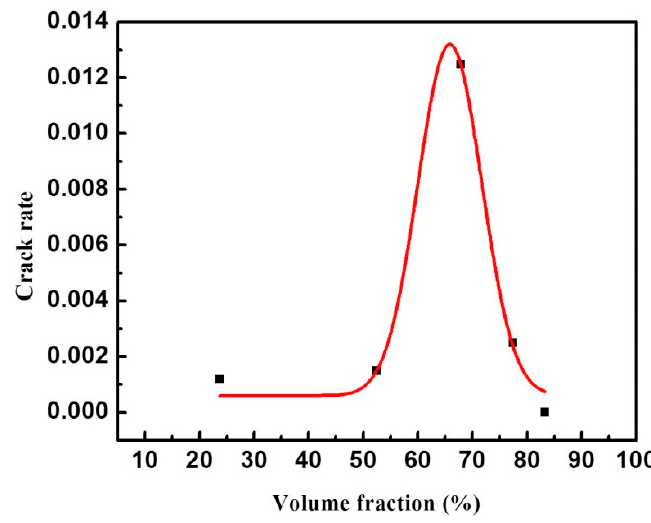
Figure 11. Fitting results of the crack rate with different volume fractions of α‐ Fe phase.